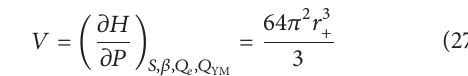
= 2 , 𝑄 = 1 . The isobars on 𝑇 - 𝑟 𝑒 + plot correspond one-to-one with the YM